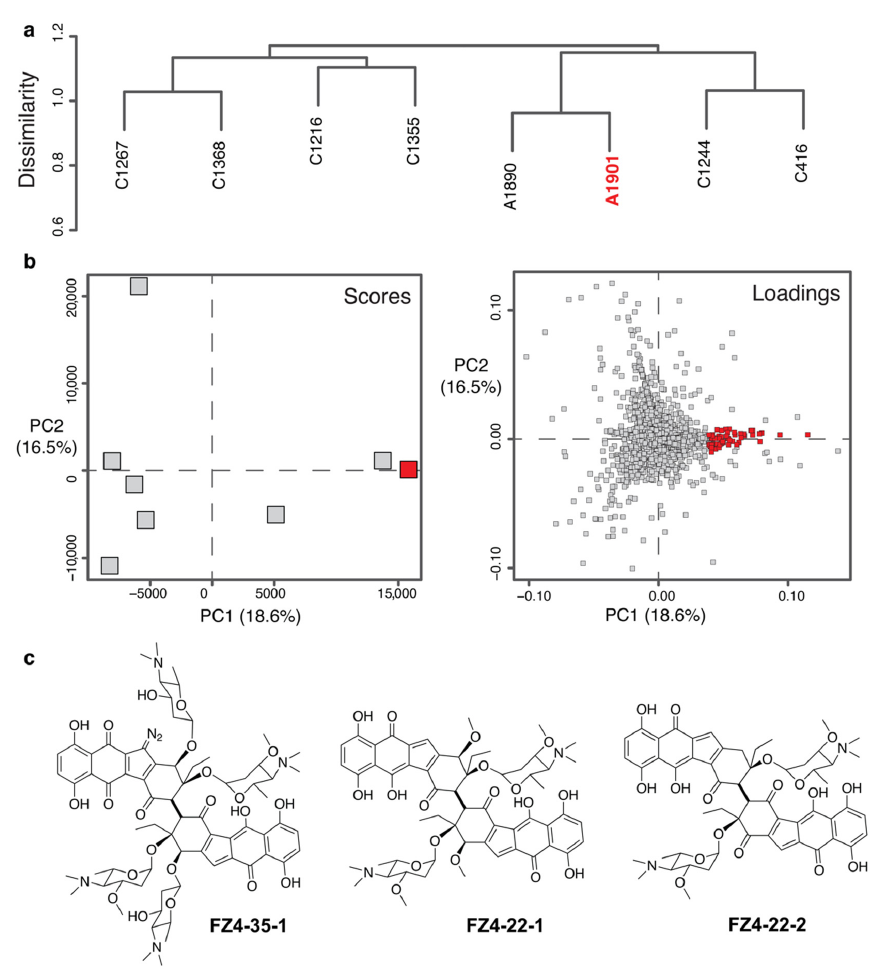
Figure 4. A1901 was identified from the PCA of node ‘fj’ shown in Figure S2. ( a ) The dendrogram of the node ‘fj’ contains eight strains in total. ( b ) PCA scores and loadings plots of the node containing A1901 with red squares highlighting the strain and its corresponding metabolites respectively are also shown. ( c ) Structures of the new lomaiviticin congeners.